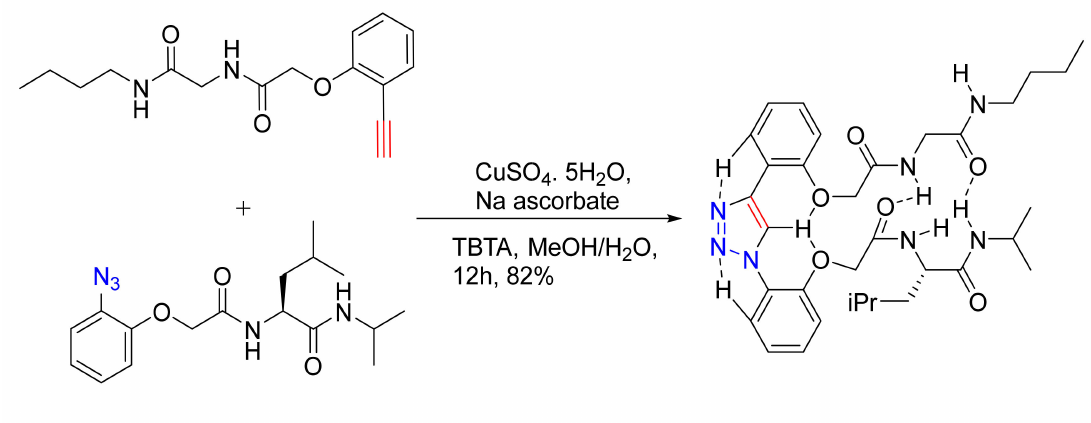
Scheme 4. Convergent synthesis of peptide mimetics adopting a β -helix conformation.